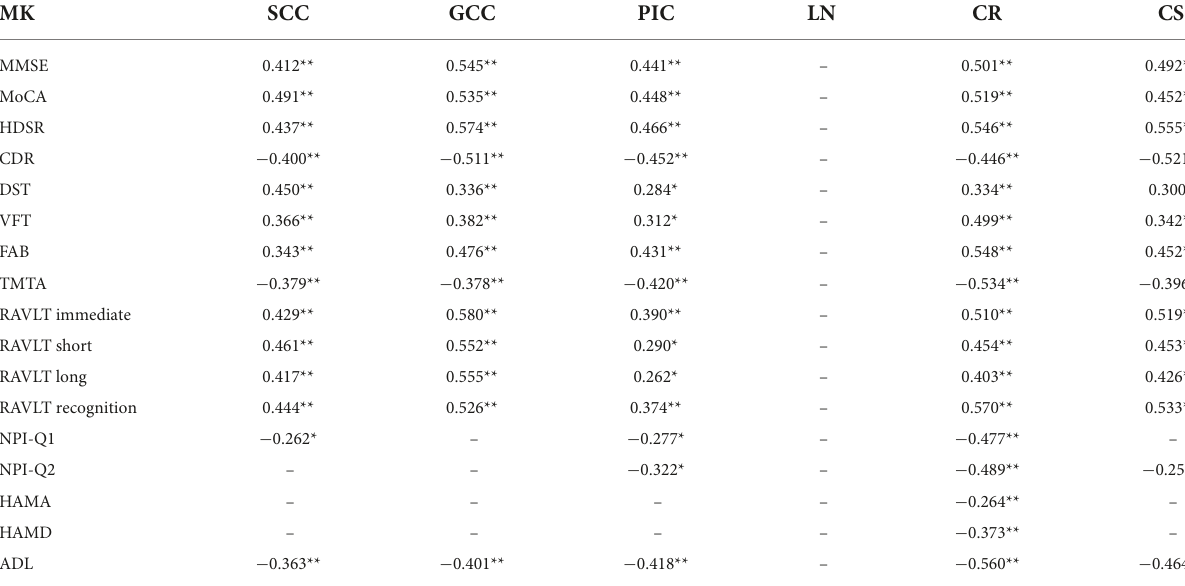
TABLE 9 Pearson’s correlation analysis between MK and neuropsychological